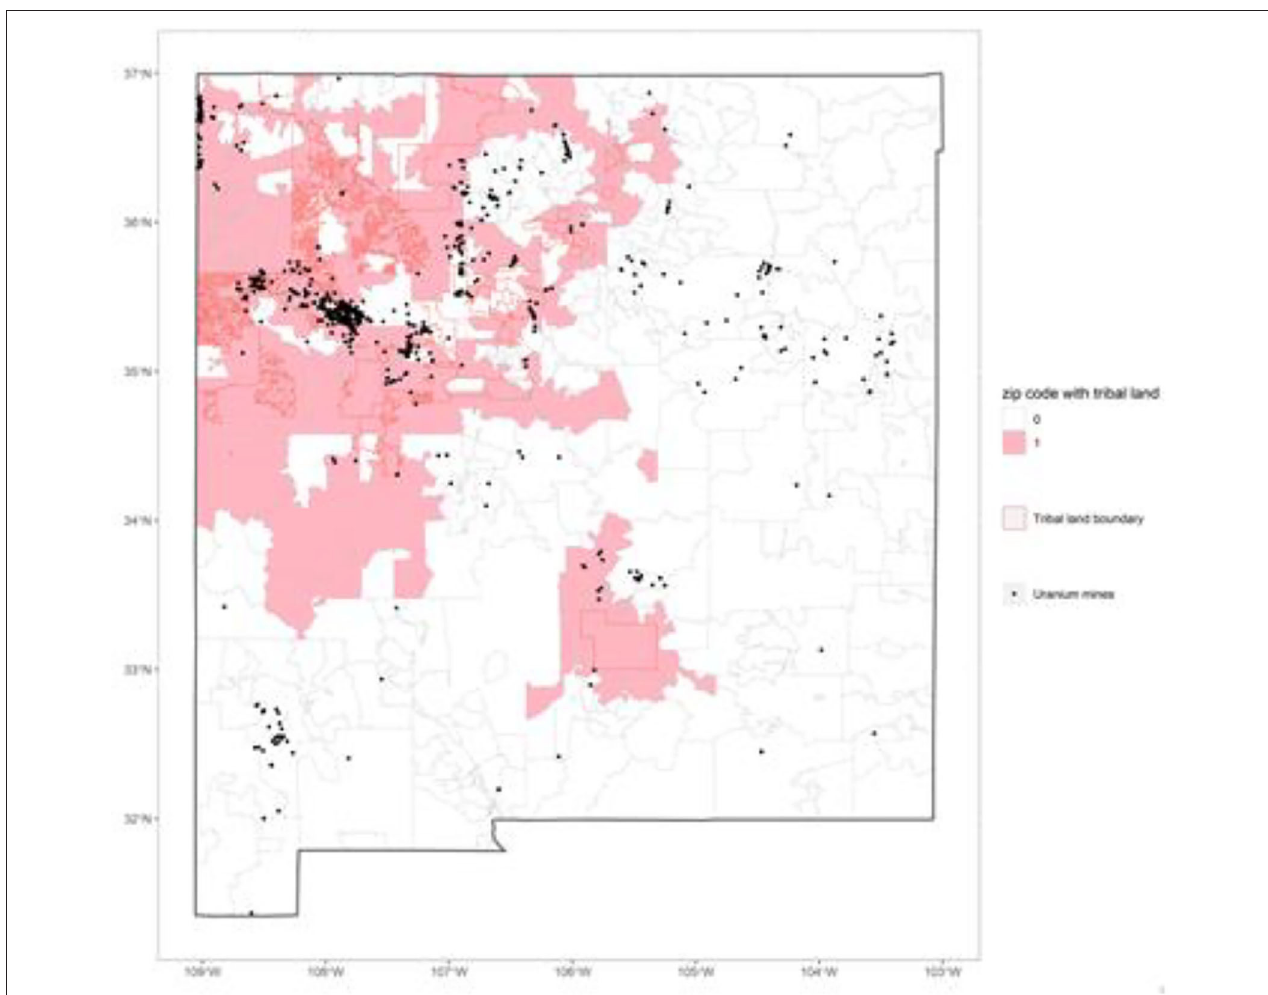
FIGURE 2 | Zip codes containing Tribal lands and abandoned uranium mines in New